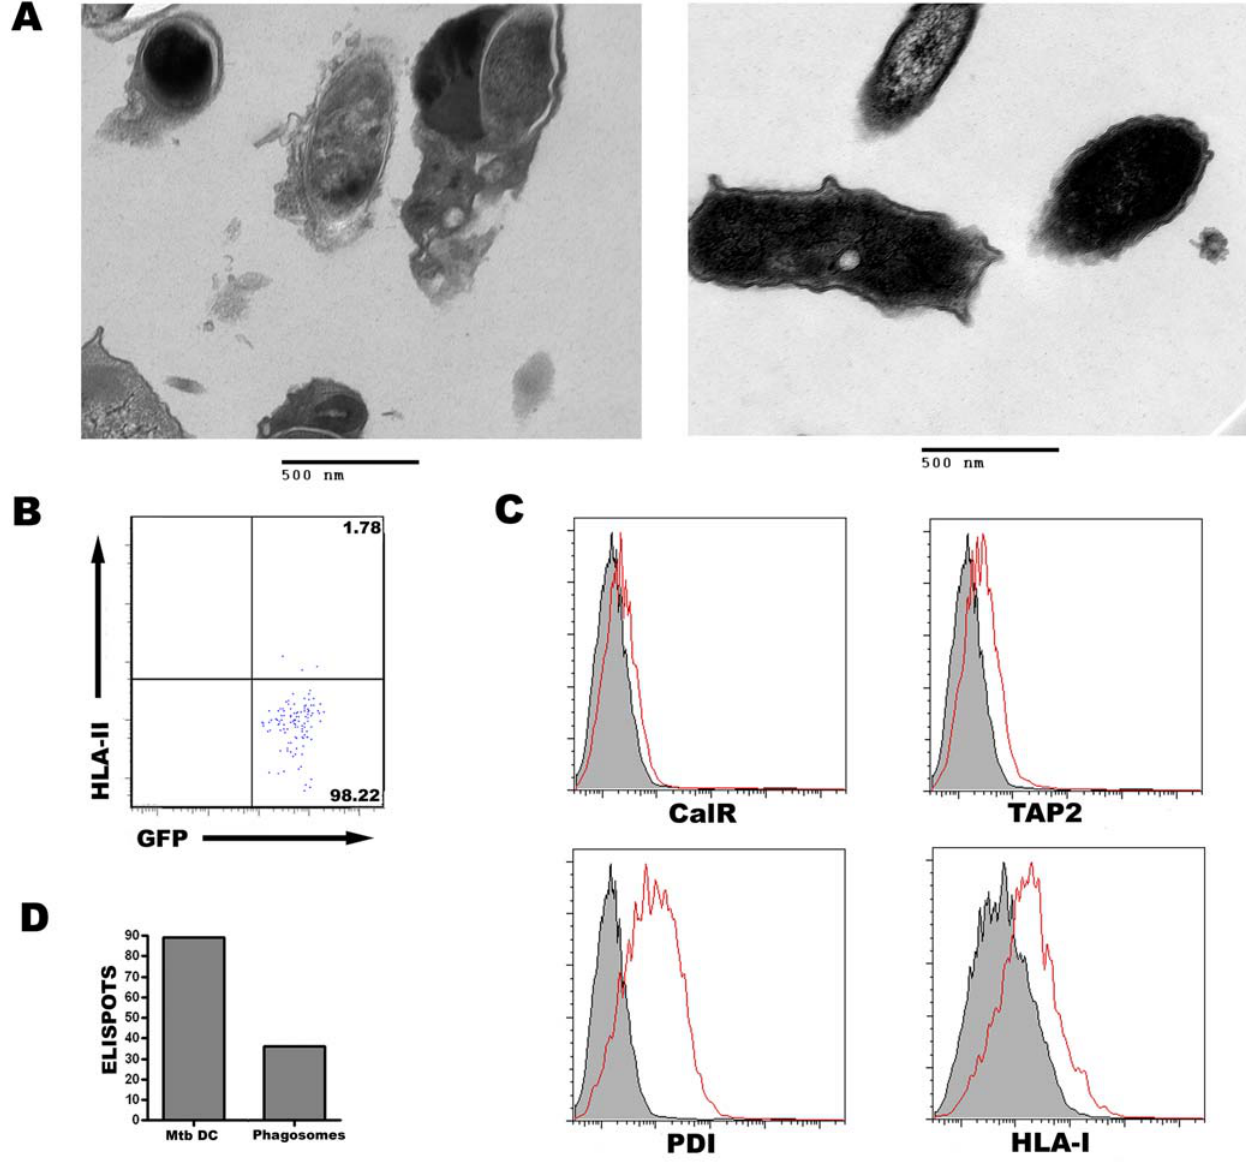
Figure 7. HLA-I, loading machinery, and HLA-I:peptide complexes are present in highly pure Mtb phagosomes. (A) Phagosomes were isolated by percoll gradient or magnetic purification and prepared for electron microscopy as described in Materials and Methods. (B) Magnetic bead- isolated phagosomes were analyzed by flow cytometry to assess HLA-II-PE (plasma membrane) and H37Rv-eGFP fluorescence as described in Materials and Methods and Figure 6. The events shown represent a small proportion of the population of phagosomes isolated and the experiment is representative of three experiments. (C) DC were pulsed with magnetically-labeled H37Rv-eGFP for 20 minutes, washed, and incubated for 18 hr. After magnetic separation of Mtb phagosomes, flow organellometry was performed as described previously. Data are representative of three experiments. (D) Magnetically-isolated Mtb phagosomes were freeze-thawed and tested for their ability to stimulate D160 1-23 CD8 + T cell clones in the absence of additional APC. IFN- c production was measured using ELISPOT. Data are representative of two